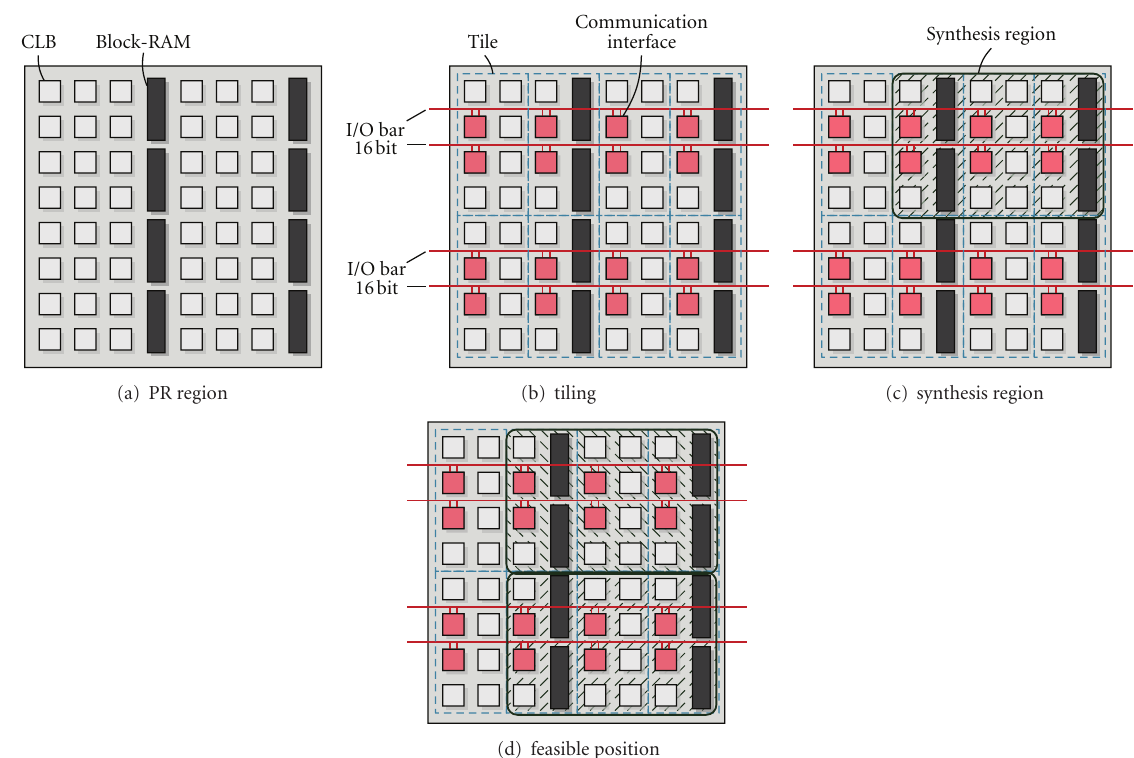
Figure 1: Example of a PR region and a possible